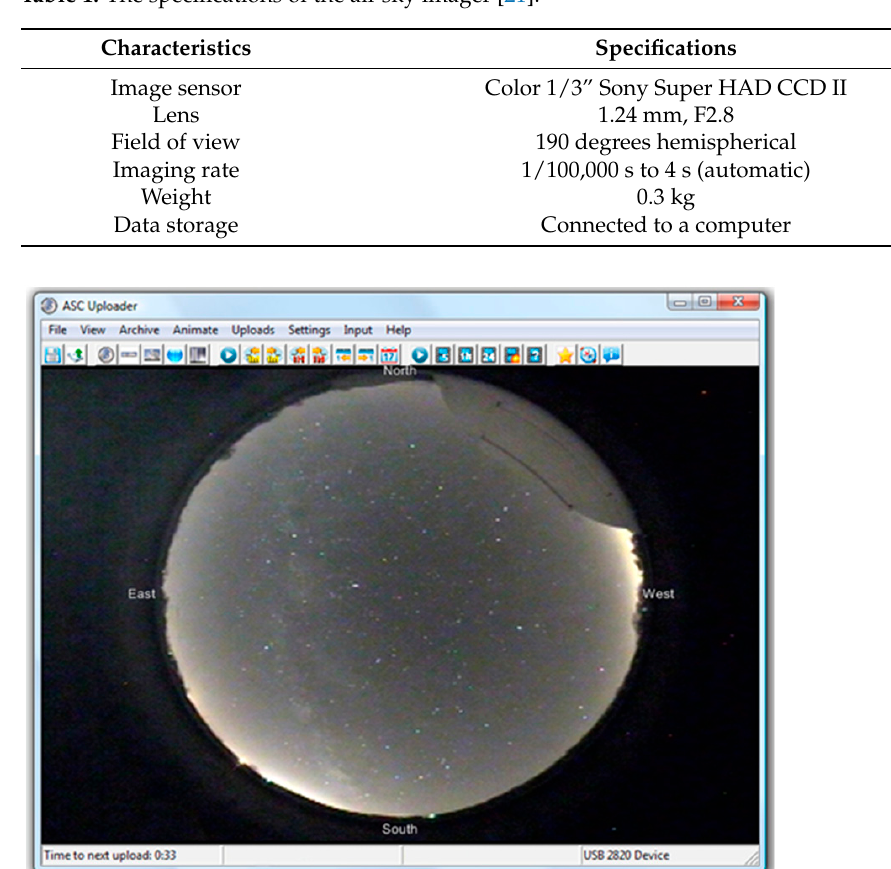
Figure 2. A snapshot of the ASC Uploader [21].